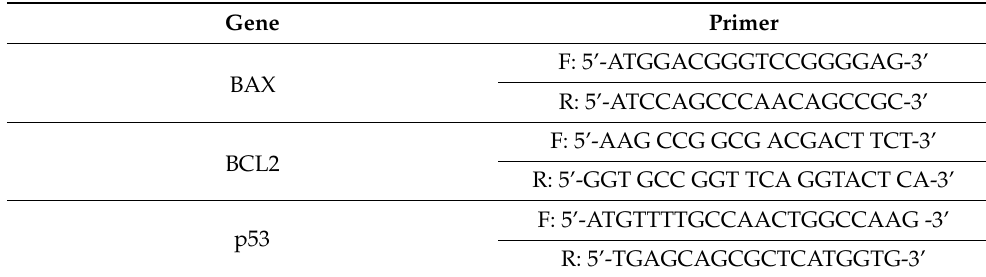
Table 1. Specific primers of BAX, BCL2, and P53 used to perform qRT-PCR analysis for PC-3 cells in response to neem extract treatment.